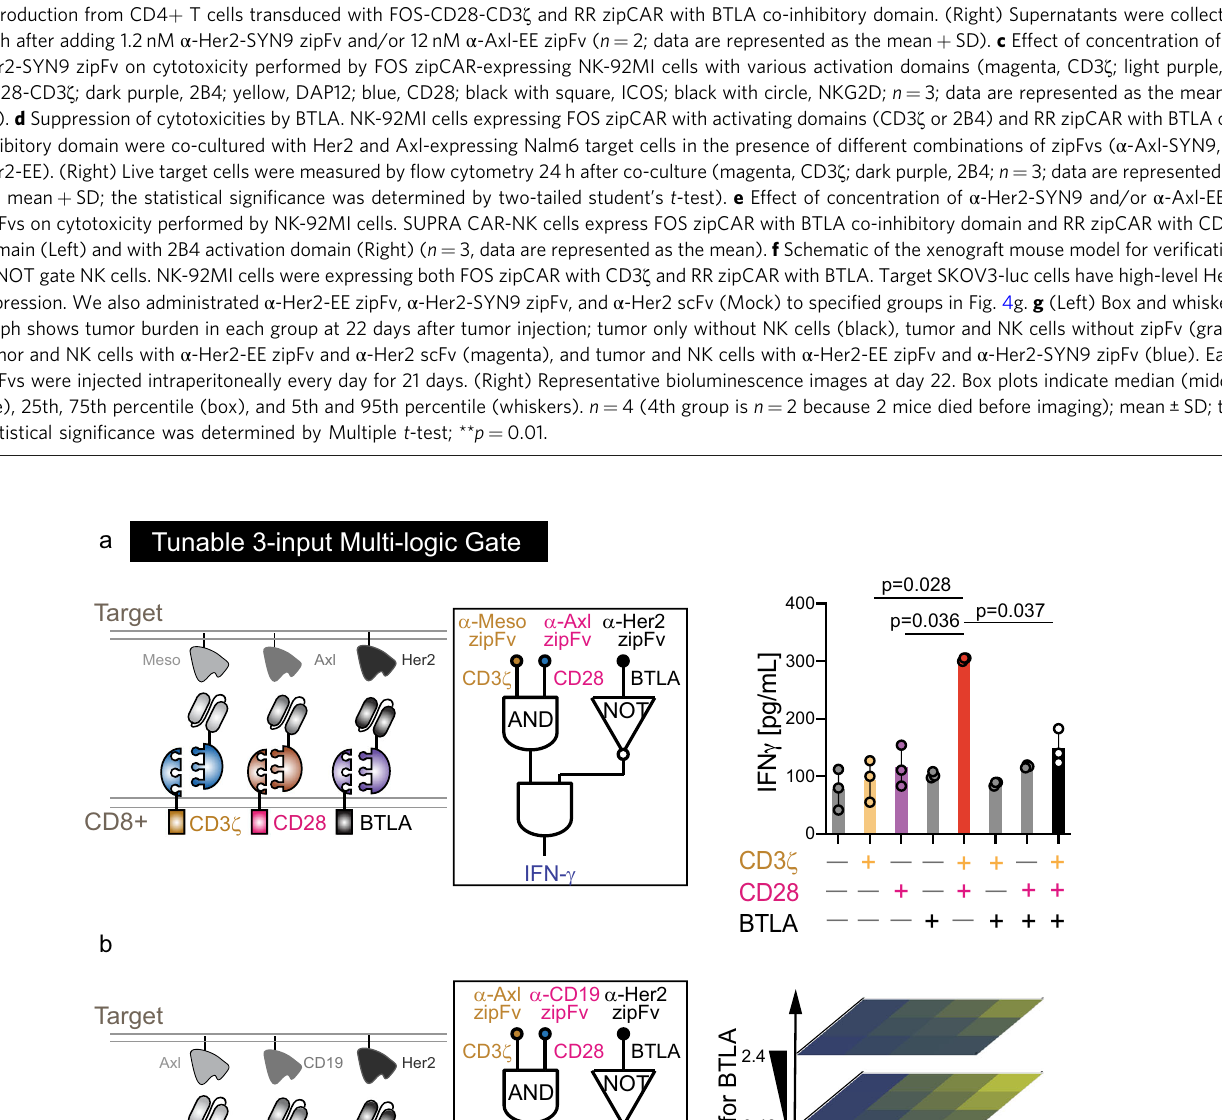
Fig. 4 The intracellular NOT logic with BTLA in different cell types. a Diagram of intracellular NOT logic with BTLA co-inhibitory signaling domain. b IFN- γ production from CD4 + T cells transduced with FOS-CD28-CD3 ζ and RR zipCAR with BTLA co-inhibitory domain. (Right) Supernatants were collected